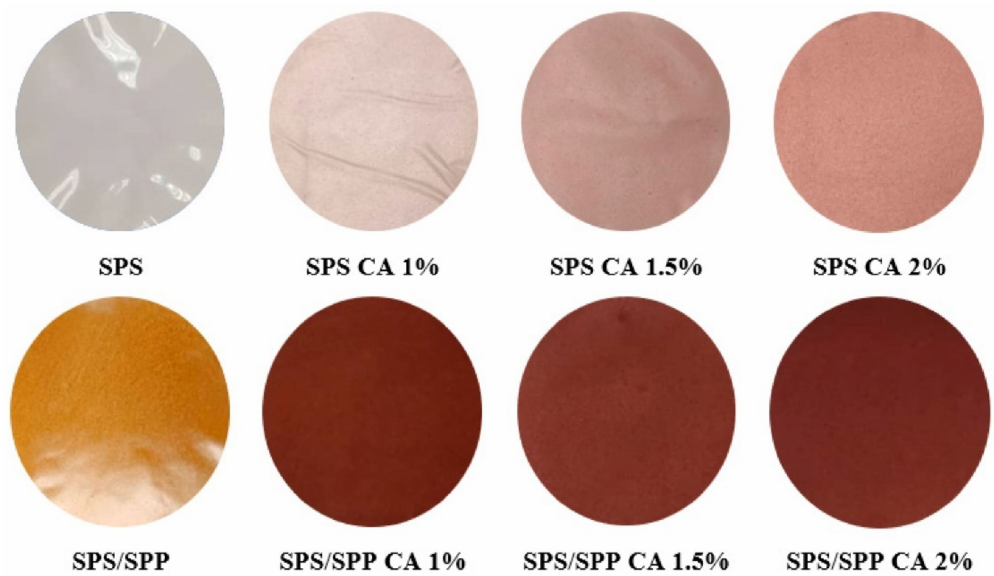
Figure 4. Visual appearance of SPS and SPS/SPP films at CA of 0, 1, 1.5, and 2%. Reproduced with permission from Ref. [52]. Copyright 2021 Taylor &